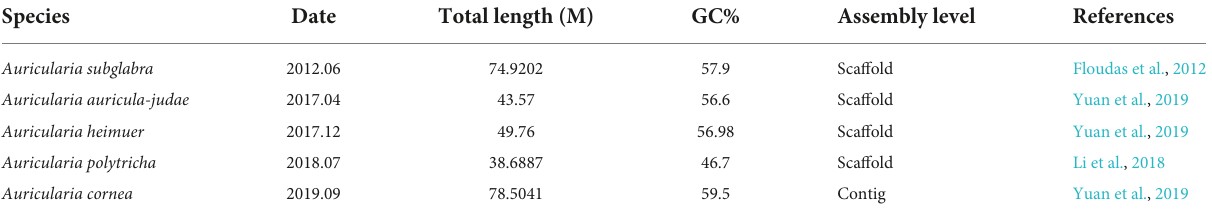
TABLE 3 Genomes of different species of Auricularia